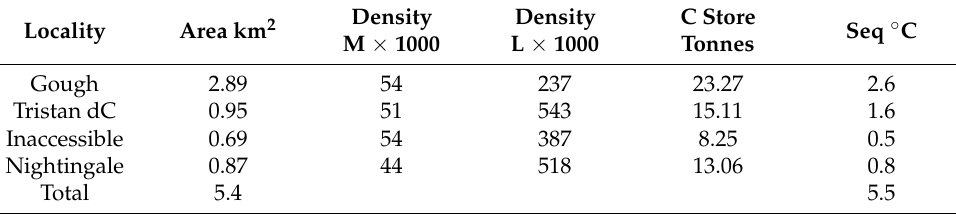
islands archipelago. The densities of kelp; Macrocystis pyrifera (M) and Laminaria pallida (L) [30]. Carbon storage of (C store) was calculated for each island as area × density × carbon mass for each of the two kelp types. This was Macrocystis [mean wet mass 1 kg × drymass conversion (0.115) = 0.115 kg drymass; × 0.3 carbon conversion = 0.035 kg carbon [33] + Laminaria (mean wet mass 0.8 kg × 0.13 = 0.104 kg dry mass, and × 0.252 = 0.026 kg Carbon [32]. Carbon export was not